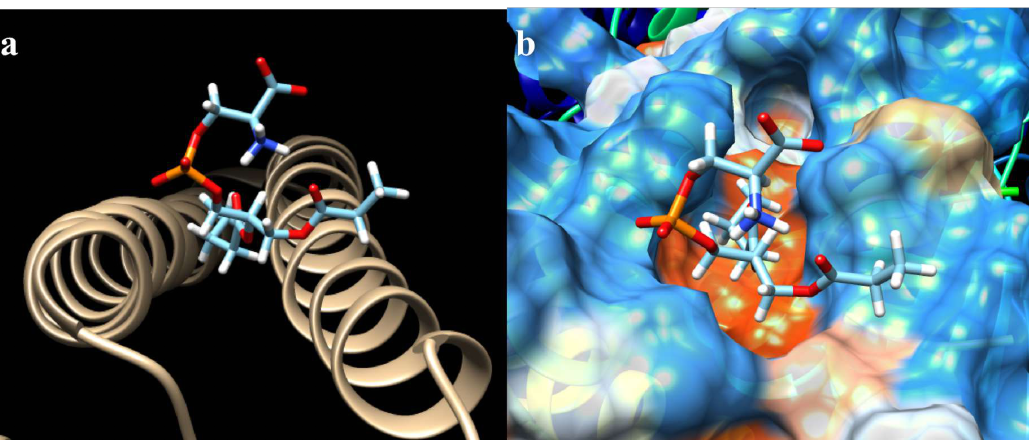
Figure 3. CagA–PS interaction of the mutation K636A obtained from Chimera: ( a ) hydrogen bonds were not found for this particular binding model; ( b ) hydrophobic surface view of CagA, color-coded from dodger blue for the most hydrophilic, to white, to orange-red for the most hydrophobic.